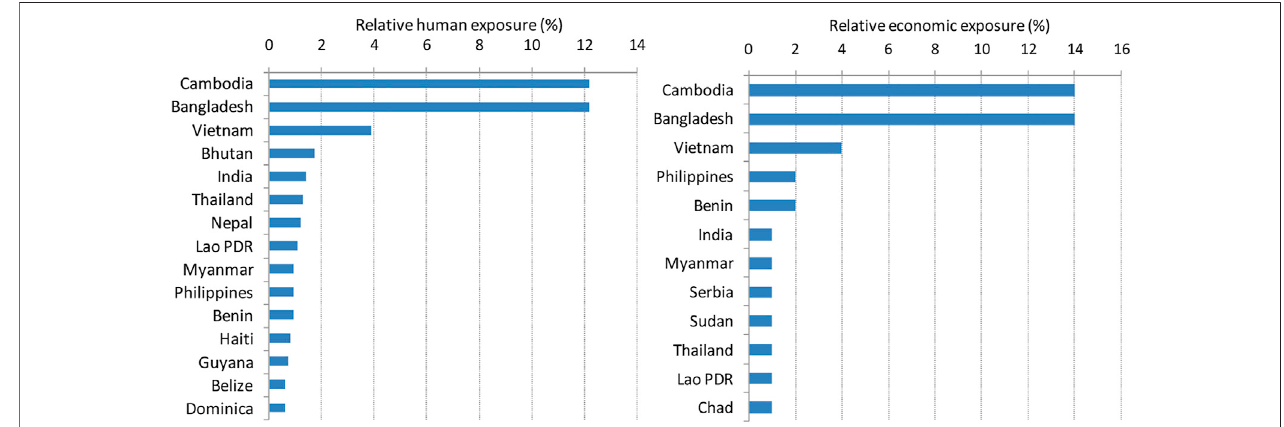
FIGURE 2 | Human exposure and economic exposure to fl oods (UNISDR,